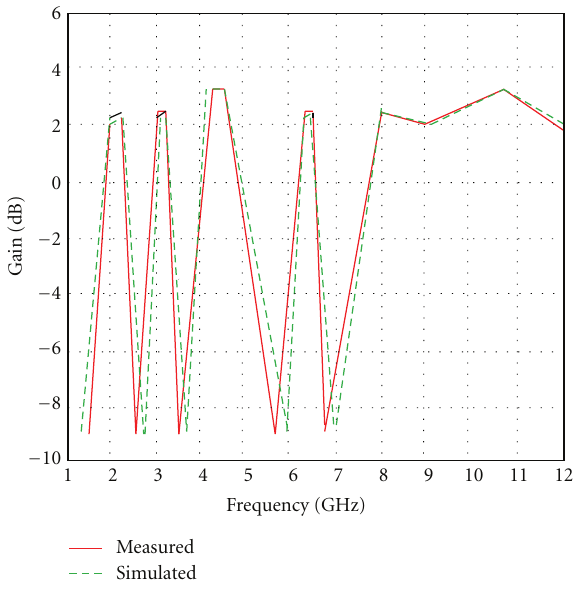
Figure 9: Gain curve of the proposed